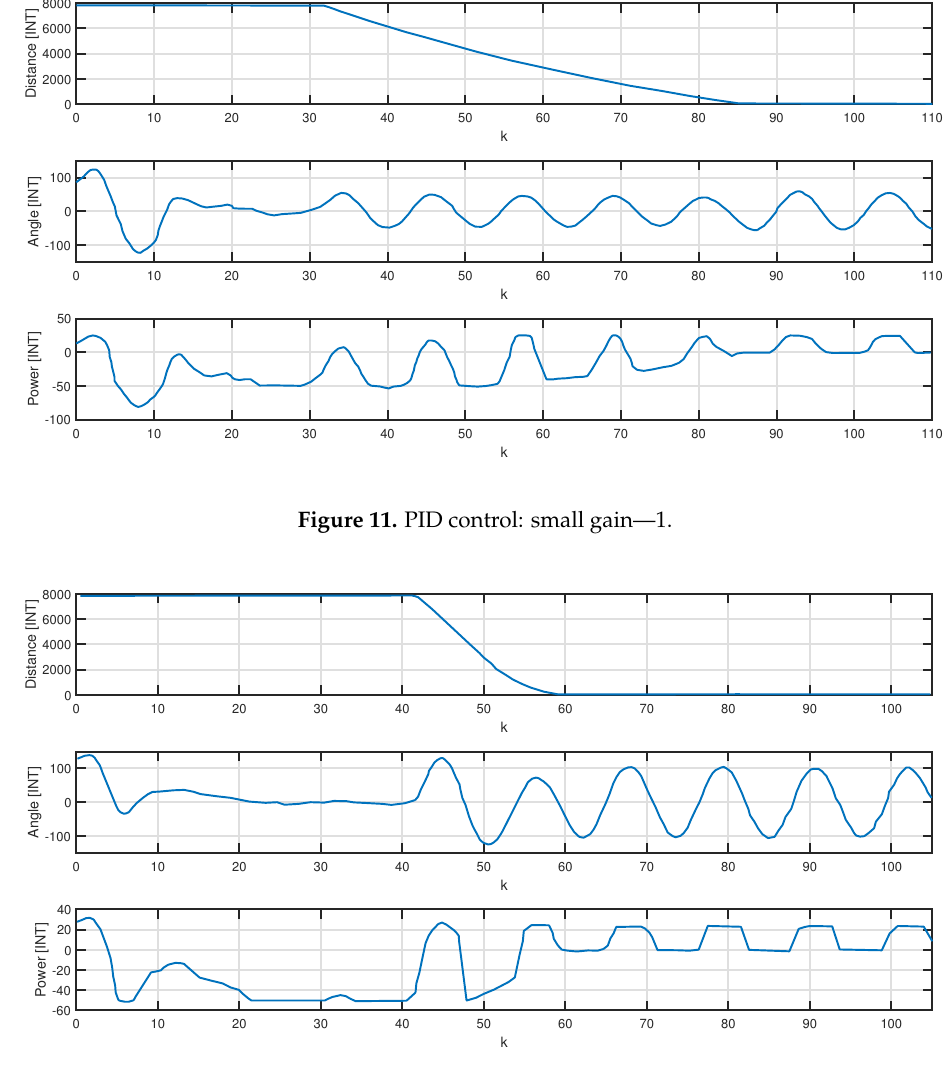
Figure 12. PID control: greater